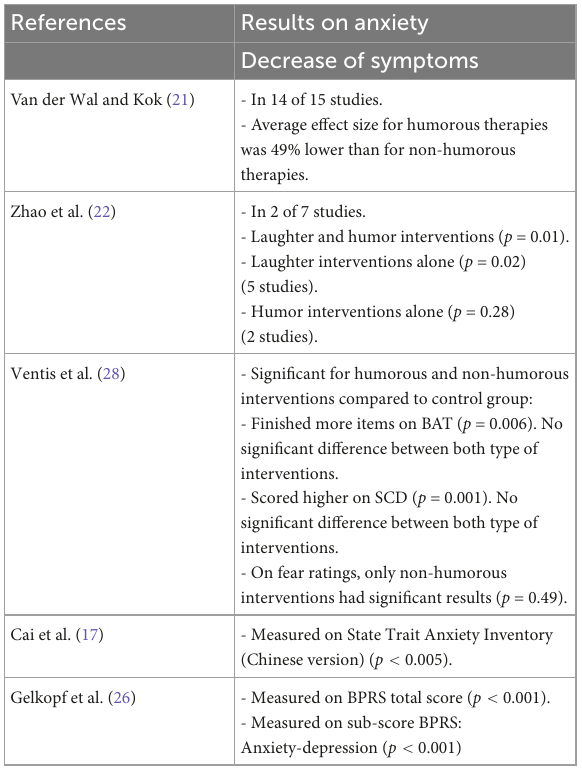
TABLE 4 Results on anxiety